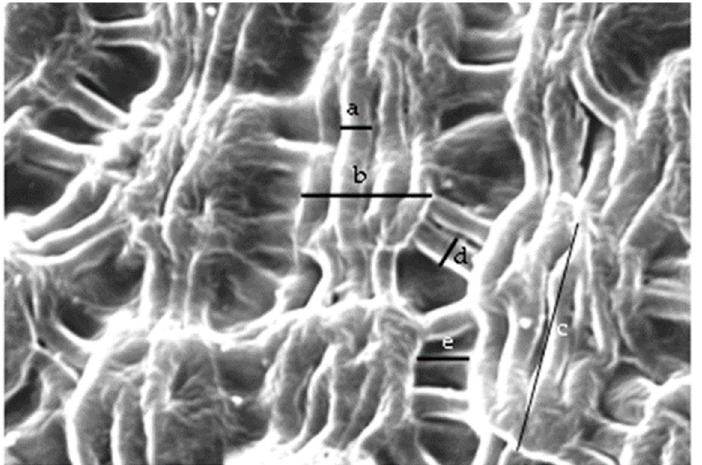
Figure 1. Cuticle ornamentation in R. idaeus nectary epidermis with marked morphometric measurements of the nectary: (a) width of band-forming striae, (b) width of cuticle bands, (c) length of cuticle bands, (d) width of striae (in the interband region) connecting cuticle bands, (e) distance between cuticle bands.